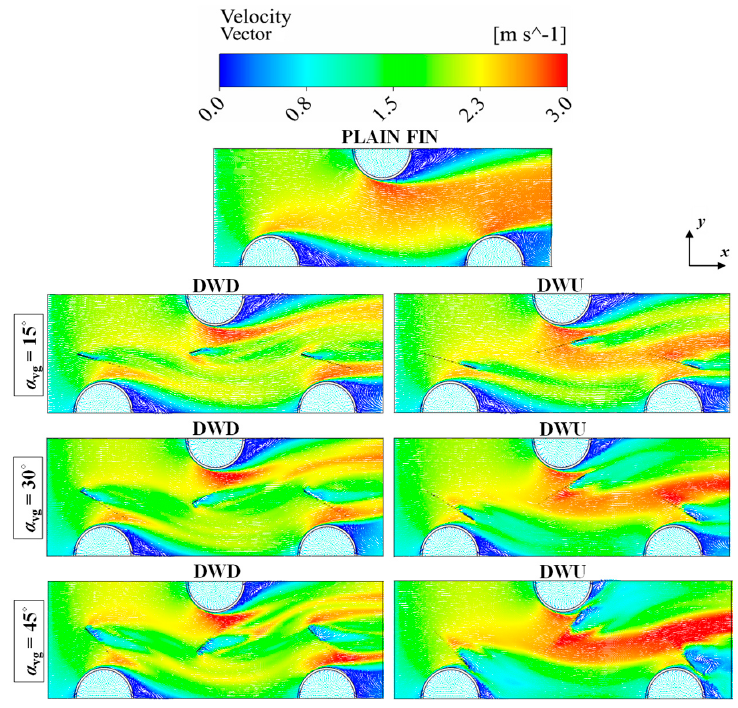
Figure 13. Velocity vectors at central plane z = 1.405 mm for air − to − water FTHEXs with plain fins and fins with DWD and DWU types of vortex generators. Test conditions: T air,in = 22 °C, T water,in = 40 °C, w air,in = 1.03 m/s, w water,in = 0.76 m/s.